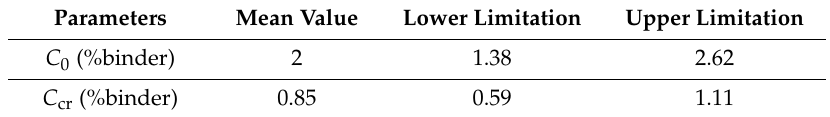
Table 4. The ranges of parameter values for surface chloride and threshold chloride concentrations.